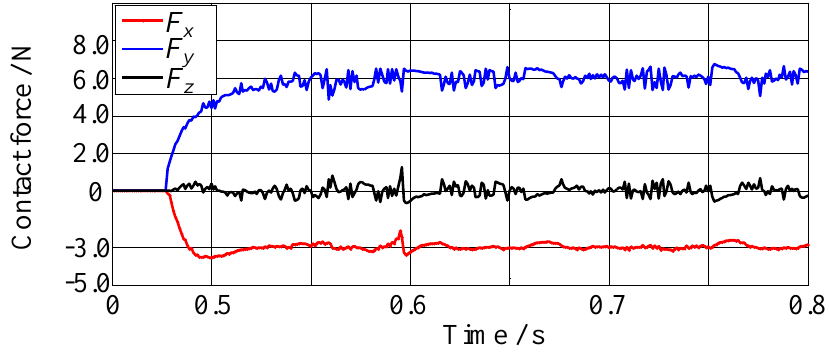
Figure 14. The force tracking results when environment stiffness is 10,000 N/m.